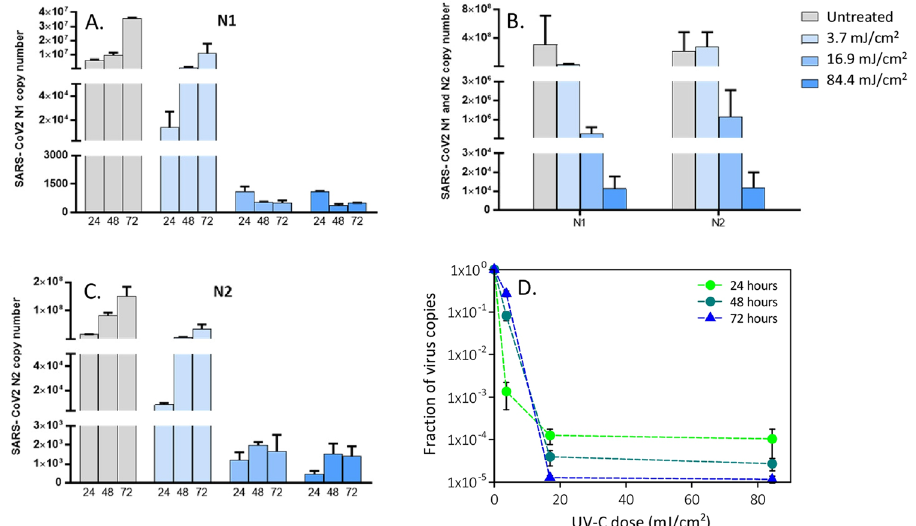
Figure 4. Viral replication of UV-irradiated SARS-CoV-2 (1000 MOI) virus in in vitro VeroE6 cells. Vero E6 cells were infected with UV-C irradiated SARS-CoV-2 virus at a MOI of 1000. Culture supernatants were harvested at the indicated times (24, 48 and 72 h) and virus titers were measured ( A , B ) by absolute copy number quantification (Real-Time PCR). Viral replication was assessed even on cell lysate harvested at the end of cell cultures (72 h) ( C ). All cell culture conditions were seeded in duplicate. Panel ( D ) reports the plots of the measured virus copies normalized at the untreated sample in the different conditions. For descriptive purposes, mean values and whiskers representing the observed half-ranges are